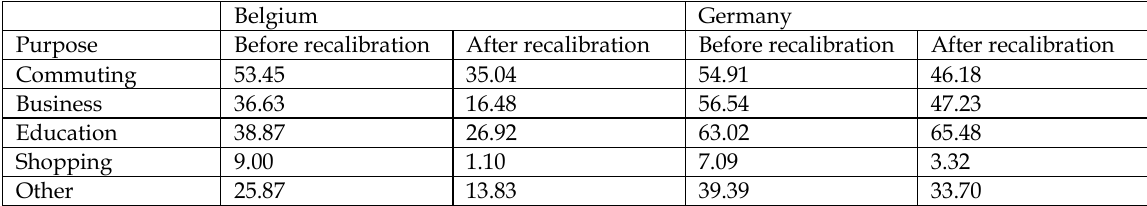
Table 6. Border resistance expressed in minutes travel